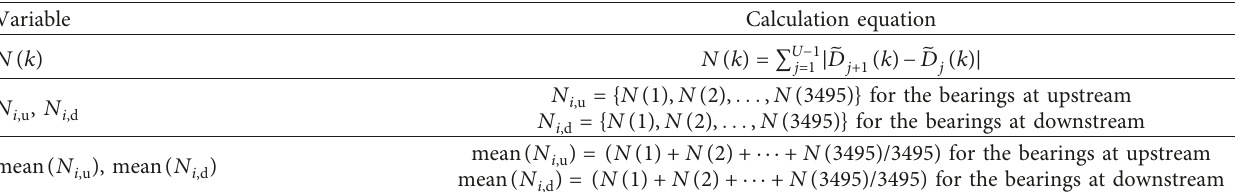
Table 1: Calculation of variables N ( k ) , N